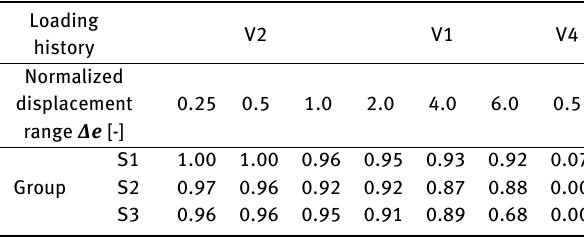
Table 4: Deterioration of resistance ε ( ∆e ) for V1, V2 and V4 loading histories.